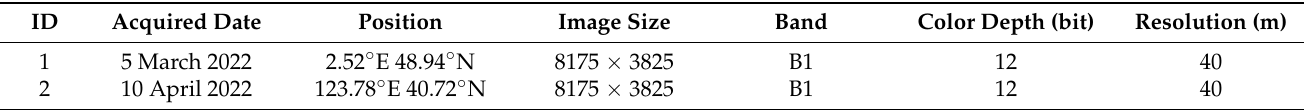
Table 3. The detailed information of two full-size images.